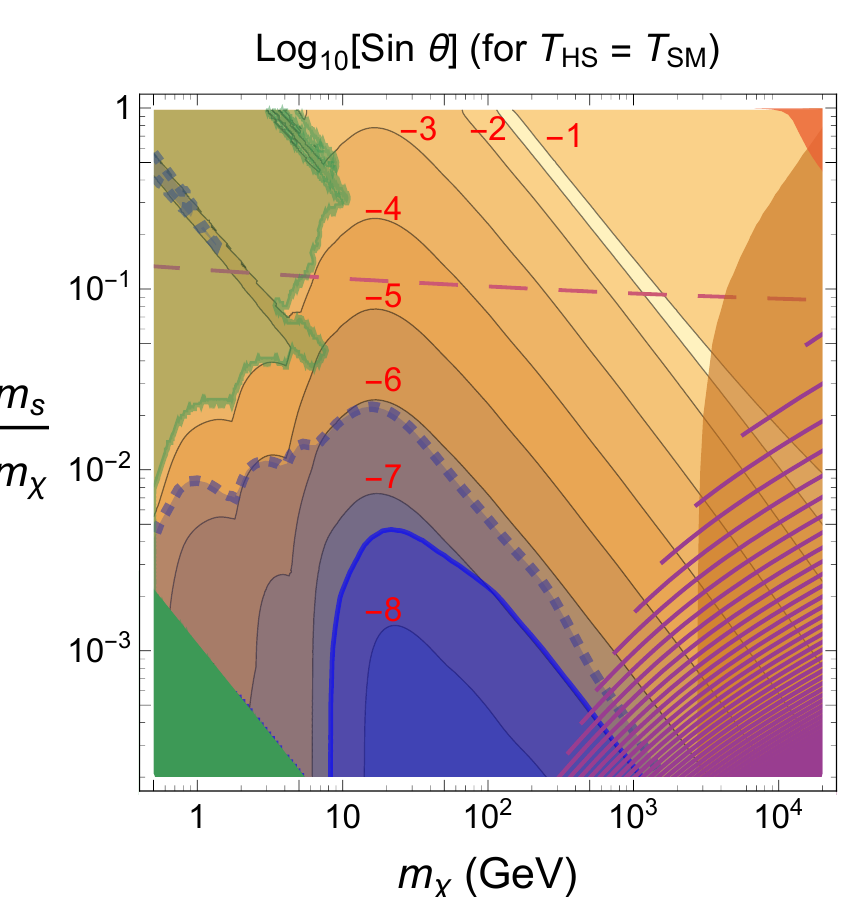
Figure 11 . Combined constraints on sin (cid:18) in the HSFO-HP model. The CMB (purple) constraints from bound state production exclude all values of sin (cid:18) under the assumption that T SM = T HS at the time of freezeout. Regions where other constraints on the mediator s (collider, beam dump, cosmology, etc.) supersede the direct detection constraints shown in (cid:12)gure 8 are shown in green. Other colors are as in (cid:12)gure